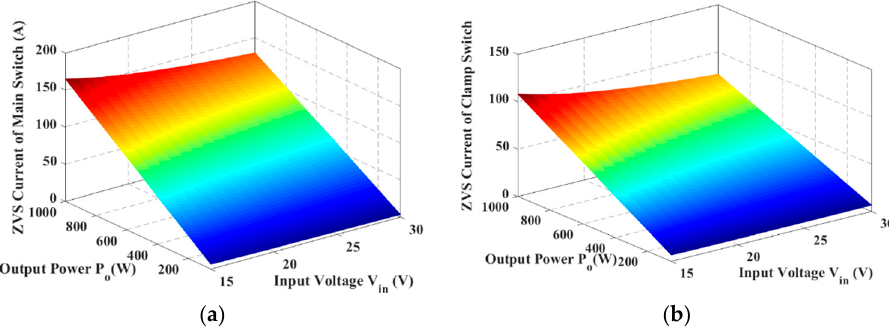
Figure 6. Soft-switching characteristics of the proposed converter. ( a ) ZVS current of the main switch; and ( b ) ZVS current of the clamp switch.